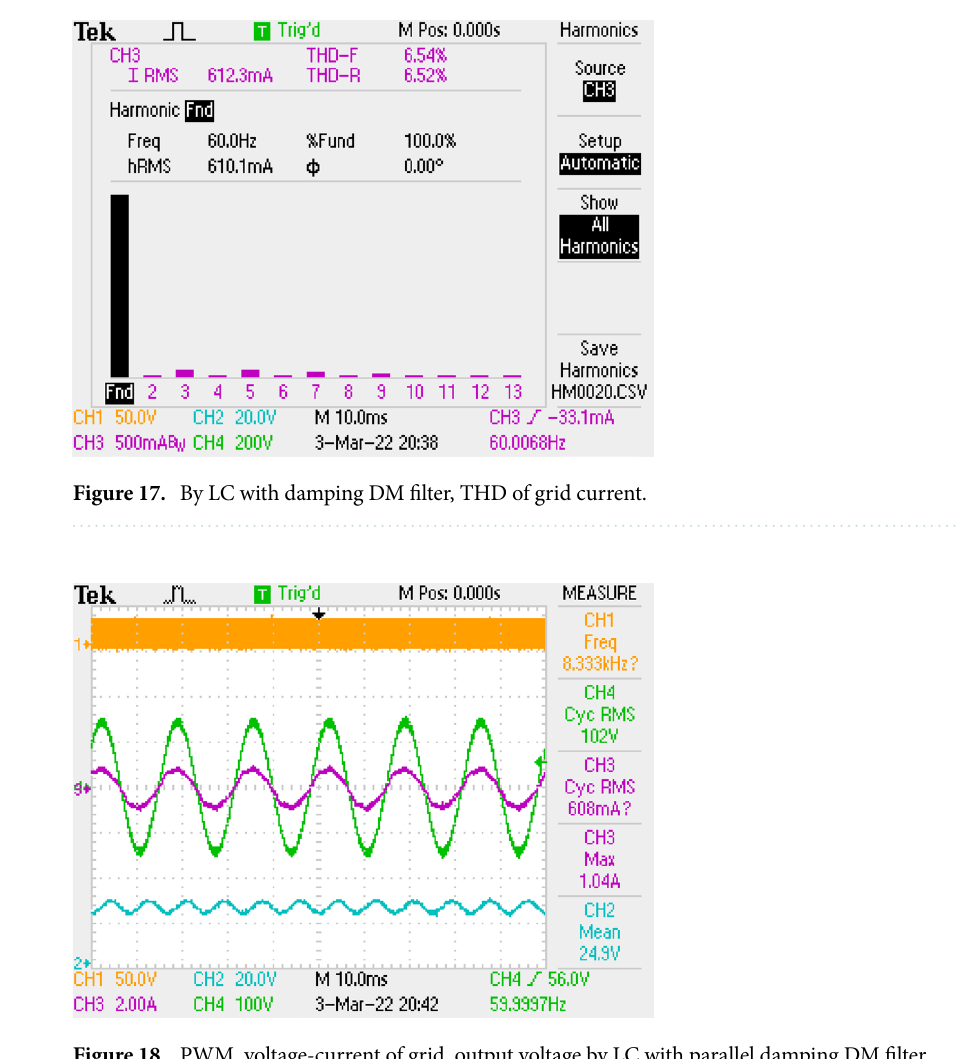
Figure 18. PWM, voltage-current of grid, output voltage by LC with parallel damping DM